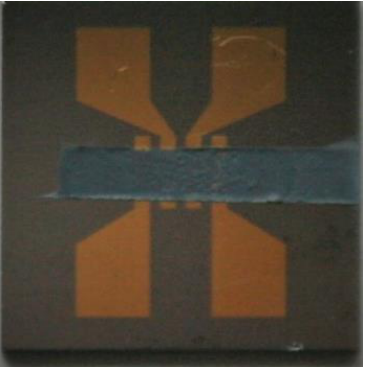
Figure 6. Gas sensing layer comprising TiO 2 nanoparticles and graphene flakes: photo of the sensor made by painting on a silicon substrate with four-point gold contacts.